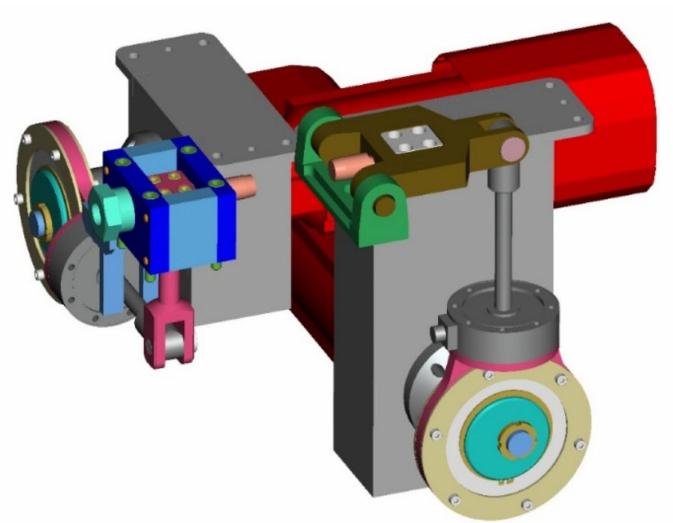
Figure 5. The 3D model of the designed mechanism for cyclic loading the tested material by bending and